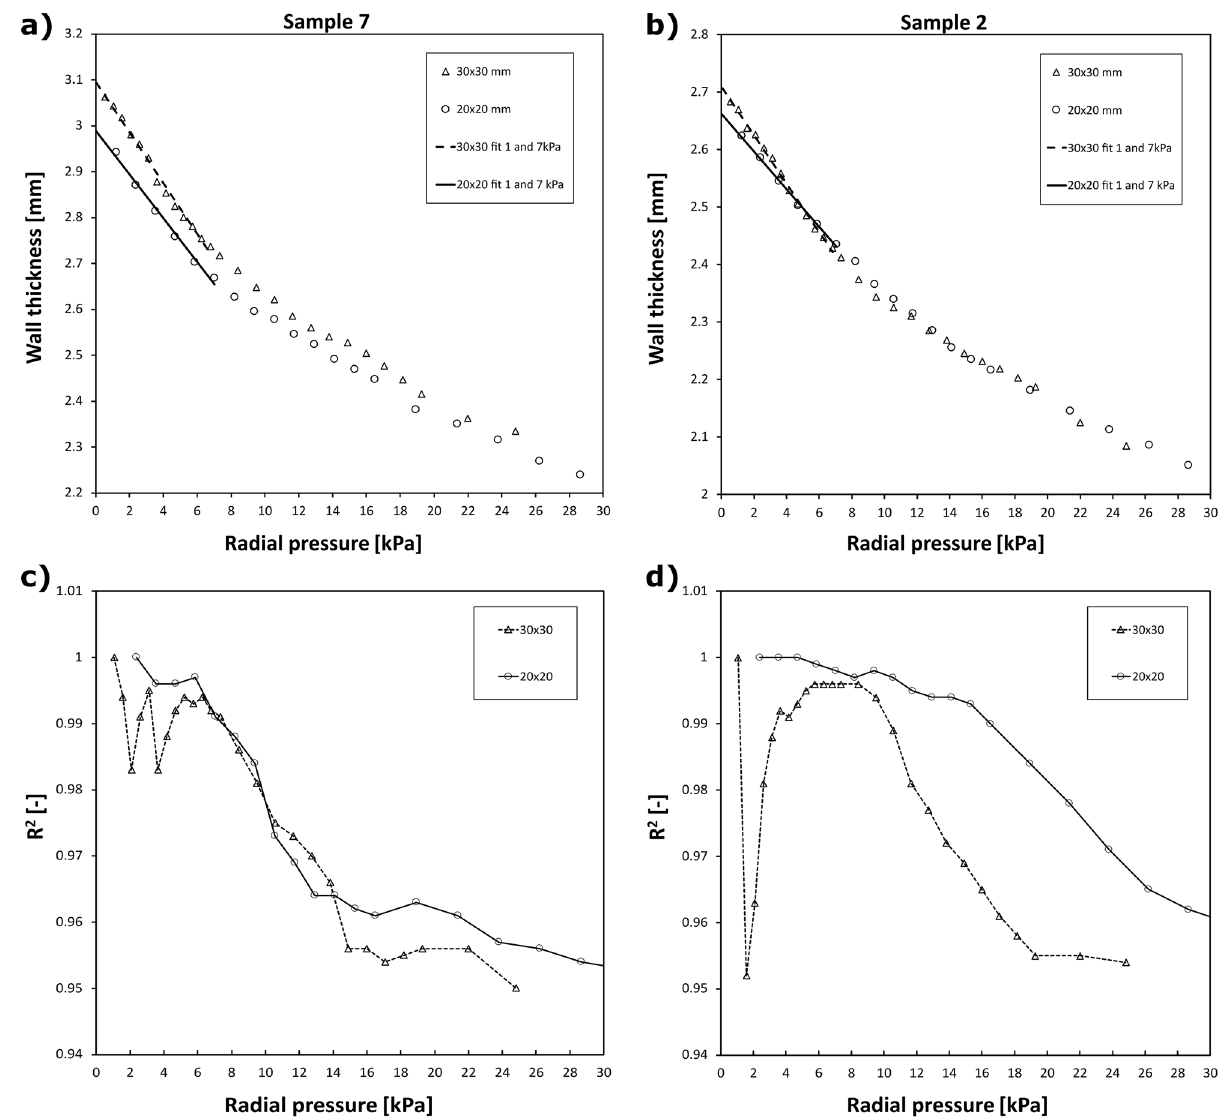
Figure 3. Typical variation of sample wall thickness as a consequence of applied radial pressure for samples 7 ( A ) and 2 ( B ) for two sample sizes 30 × 30 mm (triangles) and 20 × 20 mm (circles). The linear fit between 1 and 7 kPa extrapolated towards zero pressure for the 30 × 30 mm (dashed line) and 20 × 20 mm (solid line) samples. Lower row is the evolution of R 2 values of a linear fit when gradually leaving out points with lower pressure for samples 7 ( C ) and 2 ( D ).